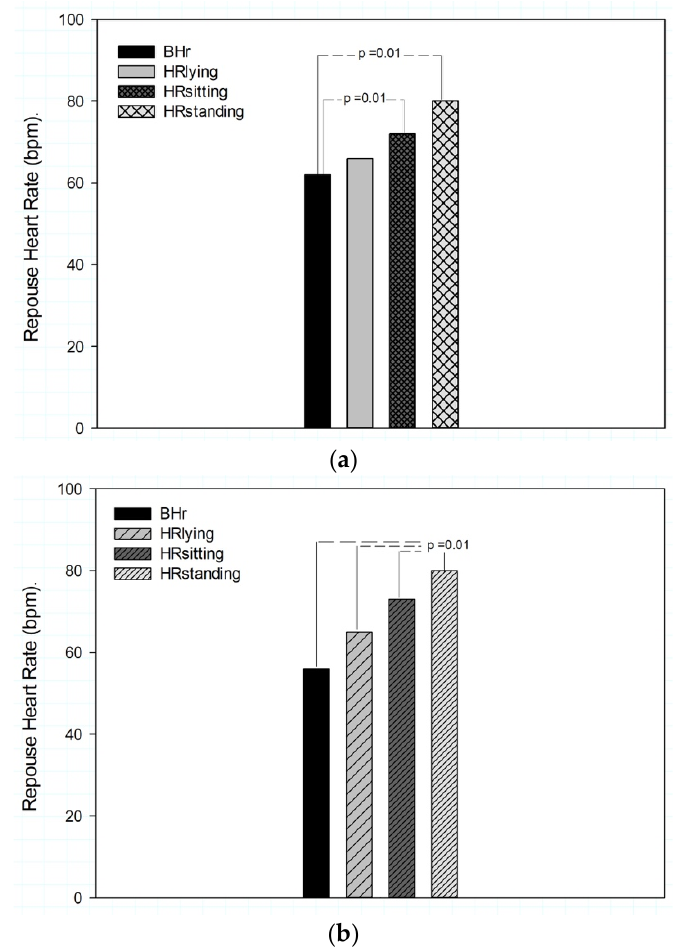
Figure 1. Baseline and resting heart rate measured in different positions. ( a ) average values of baseline and resting heart rate in different positions in 11 young women; ( b ) average values of baseline and resting heart rate in different positions in 22 young